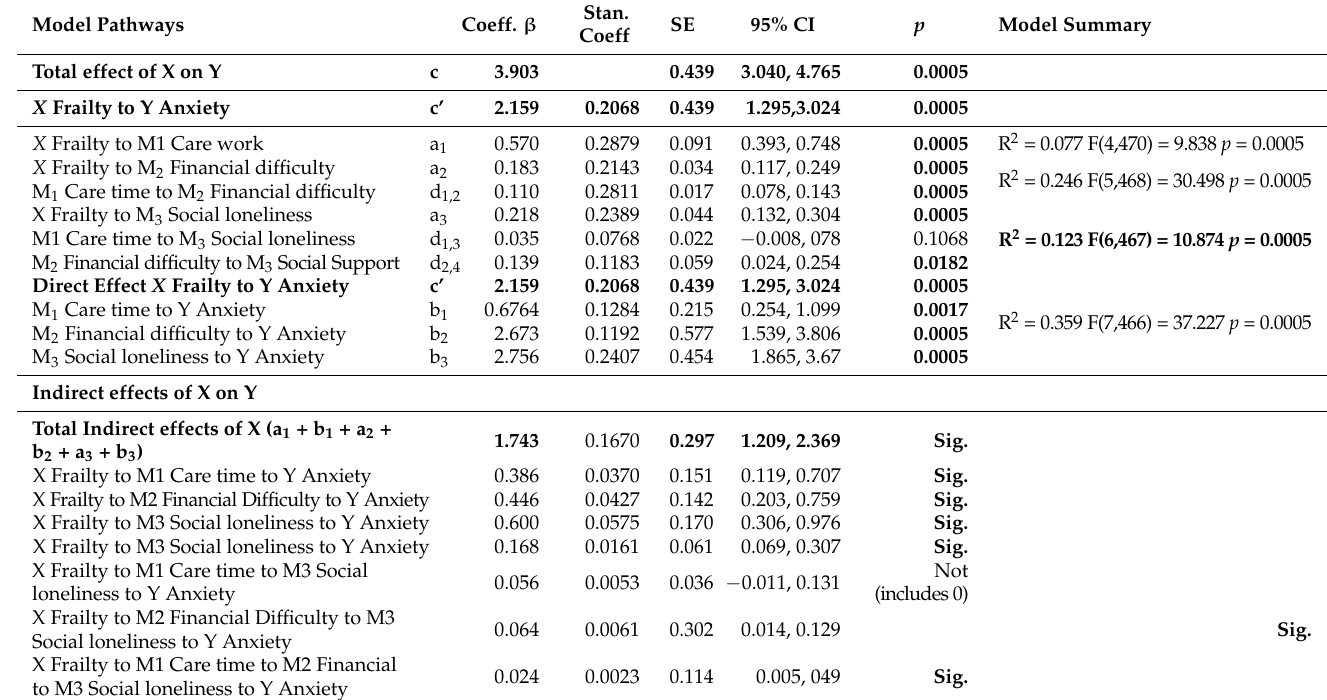
Table 4. Serial mediators in the relationship between caregiver frailty and